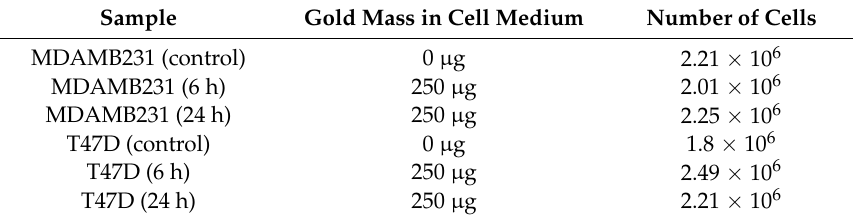
Table 2. Number of cells per condition and gold mass in the medium at the beginning of exposure.